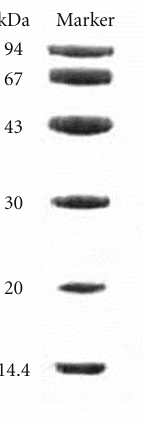
Figure 2: SDS-PAGE of A. placomyces